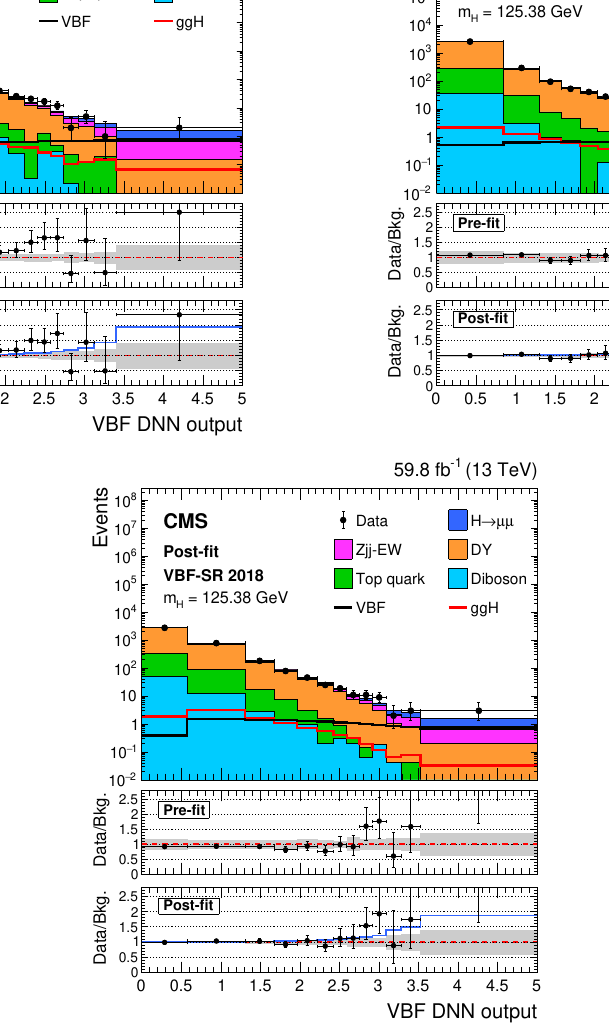
Figure 1 . The observed DNN output distribution in the VBF-SR region for data collected in 2016 (first row, upper), 2017 (first row, lower), and 2018 (second row) compared to the post-fit background estimate for the contributing SM processes. The post-fit distributions for the Higgs boson signal produced via ggH (solid red) and VBF (solid black) modes with m = 125 . 38 GeV are H overlaid. The predicted backgrounds are obtained from a S+B fit performed across analysis regions and years. In the middle panel, the ratio between data and the pre-fit background prediction is shown. The grey band indicates the total pre-fit uncertainty obtained from the systematic sources previously described. The lower panel shows the ratio between data and the post-fit background prediction from the S+B fit. The grey band indicates the total background uncertainty after performing the fit. The blue histogram (upper panel) and solid line (lower panel) indicate the total signal extracted from the fit with m = 125 . 38 H